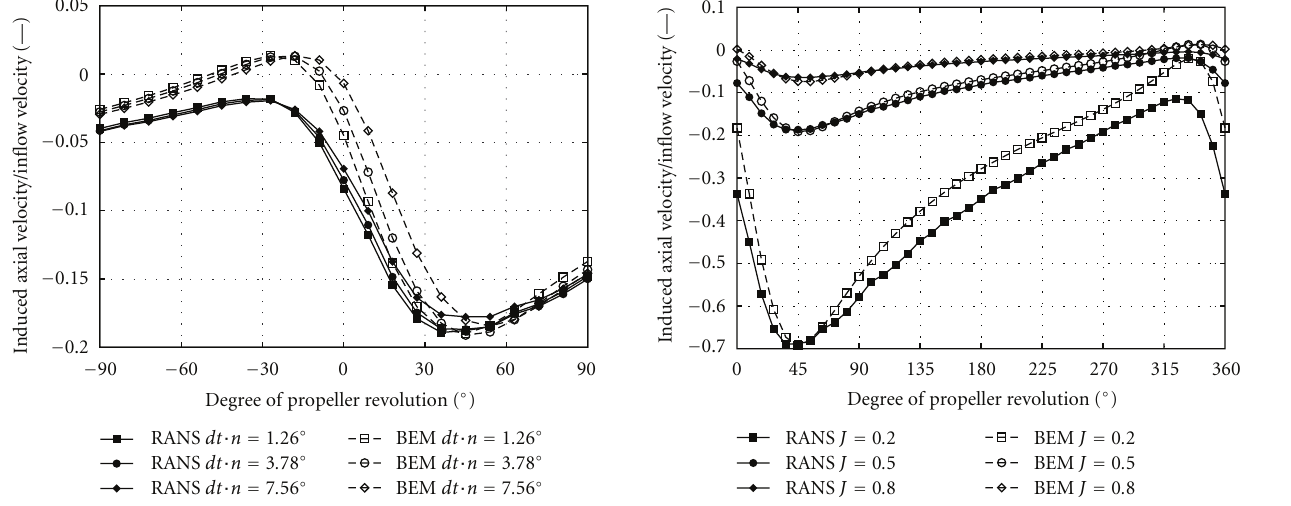
Figure 10: Comparison of the normalised induced axial velocities for di ff erent propeller advance ratios explicit coupling: ( r/R = 0 . 7, dt · n = 3 . 78 ◦ , and dx = 0 . 5 R